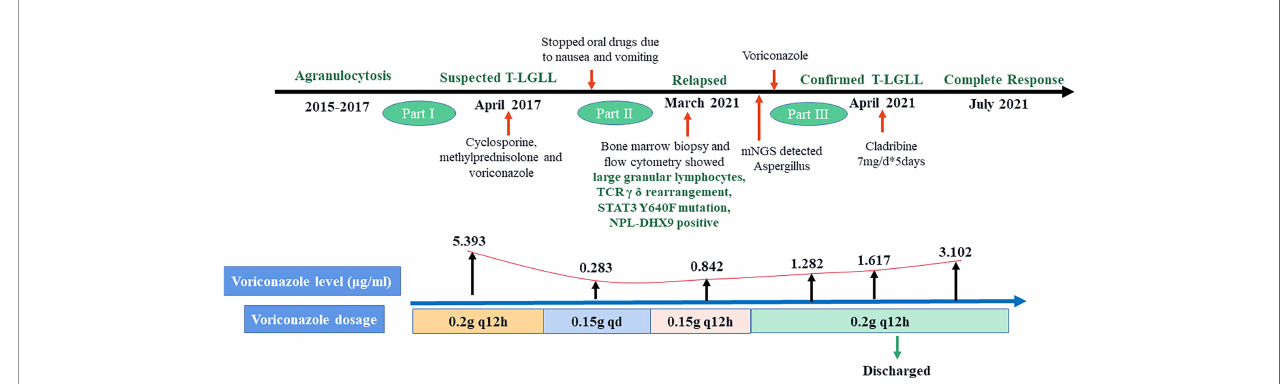
FIGURE 6 | Timeline of disease and treatment periods.